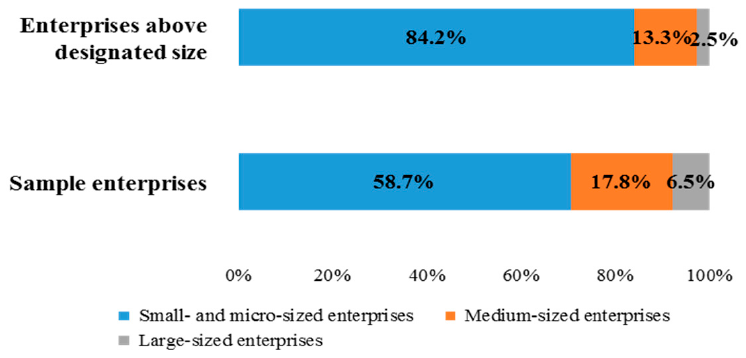
Figure 6. Scale representativeness of sample enterprises.